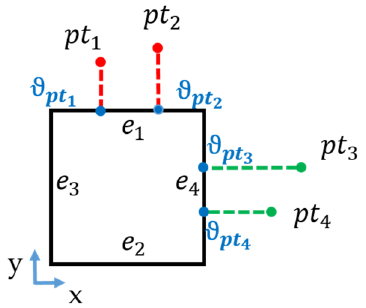
Figure 8. Sorting rule: ϑ pt are the projection points. pt 1 and pt 2 are sorted according to the x coordinate